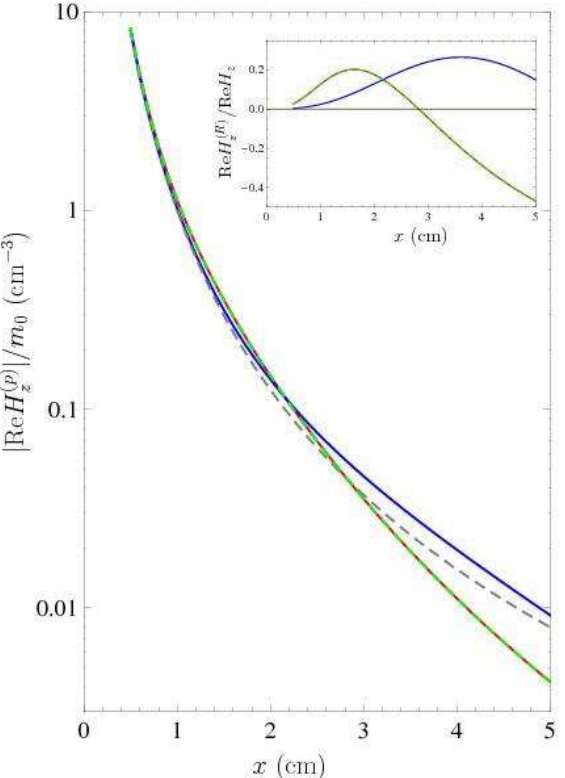
Figure 4. The normalized magnitudes of real part of the z-component of monochromatic magnetic field above the copper plate computed using the Drude model and by the plasma and spatially nonlocal models at the dipole height of 1 cm for the oscillation frequency of 100 rad/s as the functions of separation from the magnetic dipole are shown by the solid line and by another solid line overlapping with the short-dashed one, respectively. The long-dashed line demonstrates the normalized magnitude of real part of the z-component of magnetic field of oscillating dipole in the absence of metallic plate. The inset shows the ratio of real part of the z-component of reflected field to the same quantity for the dipole field in the absence of metallic plate computed using the Drude model (the solid line) and the plasma or spatially nonlocal models (the solid line overlapping with the short-dashed